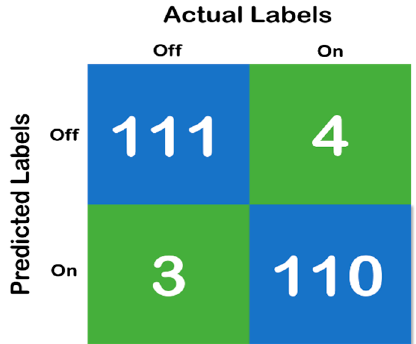
Figure 6. Confusion matrix of random forest classifier with 70:30 split, where the blue color represent the True Prediction and Green represents the Mispredictions.